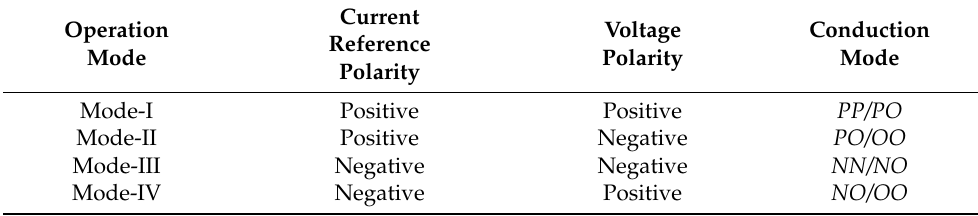
Table 3. Operation